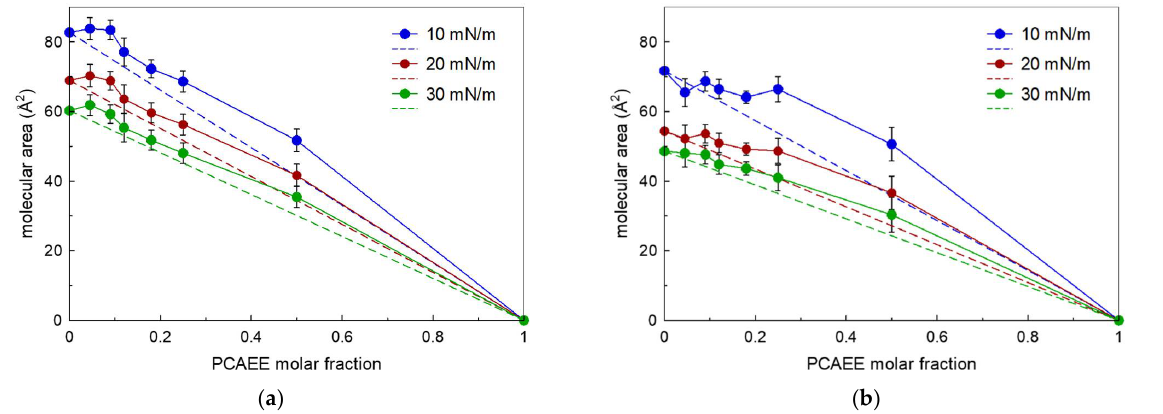
Figure 5. ( a ) Molecular area of the mixed monolayers of DMPC and PCAEE at the air–water interface plotted as a function of the mole fraction of compound at various values of surface pressures at 37 °C; ( b ) Molecular area of the mixed monolayers of DSPC and PCAEE at the air–water interface plotted as a function of the mole fraction of compound at various values of surface pressures at 37 °C.